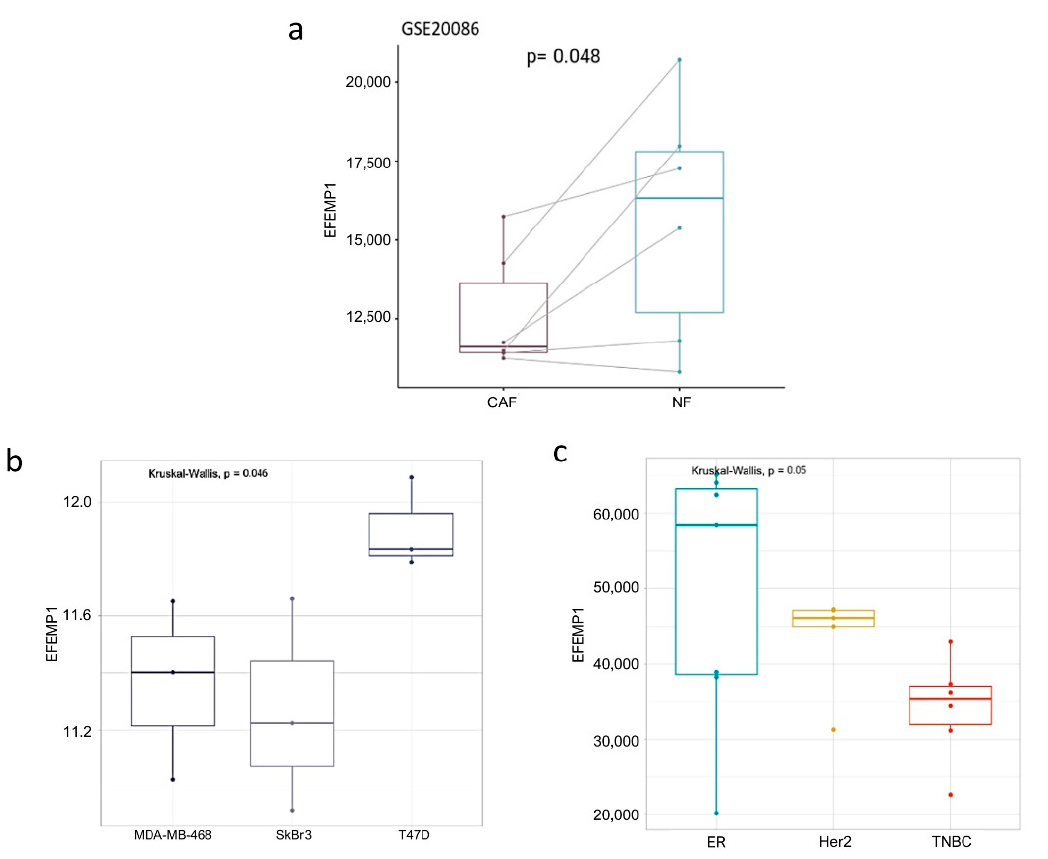
Figure 1. EFEMP1 is downregulated in breast cancer-associated and TNBC-conditioned fibroblasts. In-silico evaluation of EFEMP1 levels in paired NFs/CAFs of six breast cancer patients ( a ); in normal human dermal fibroblasts conditioned with the supernatants of breast cancer cells of different subtypes ( b ) and early passage of primary CAFs isolated from human breast cancer samples classified as ER+ ( n = 7), TNBC ( n = 7) and HER2+ ( n = 6) ( c ).